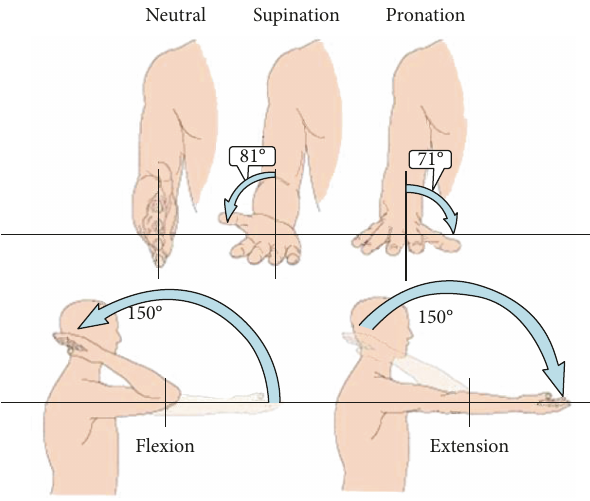
Figure 2: Normal range of motion for the elbow